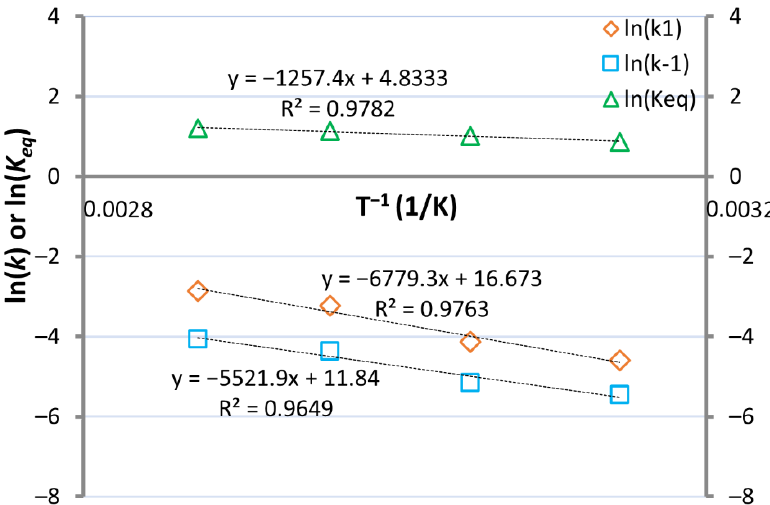
Figure 3. Arrhenius ( a ) and van’t Hoff ( b ) plots for EL synthesis through direct esterification of the respective acid and ethanol. Table 2. E a 1 , E a −1 , Δ H° and Δ S° evaluated for the direct-esterification reaction between LA and ethanol, catalyzed by AlCl 3 ·6H 2 O.